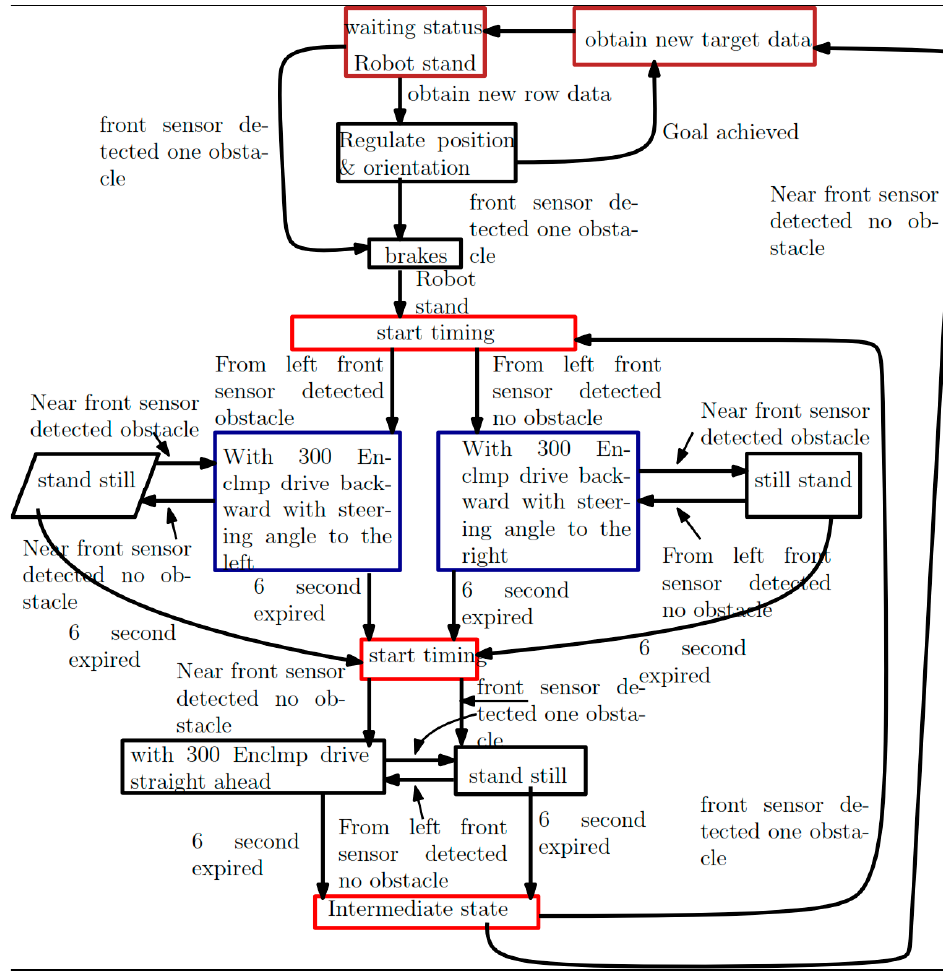
Figure 2. State machine for avoiding obstacles.